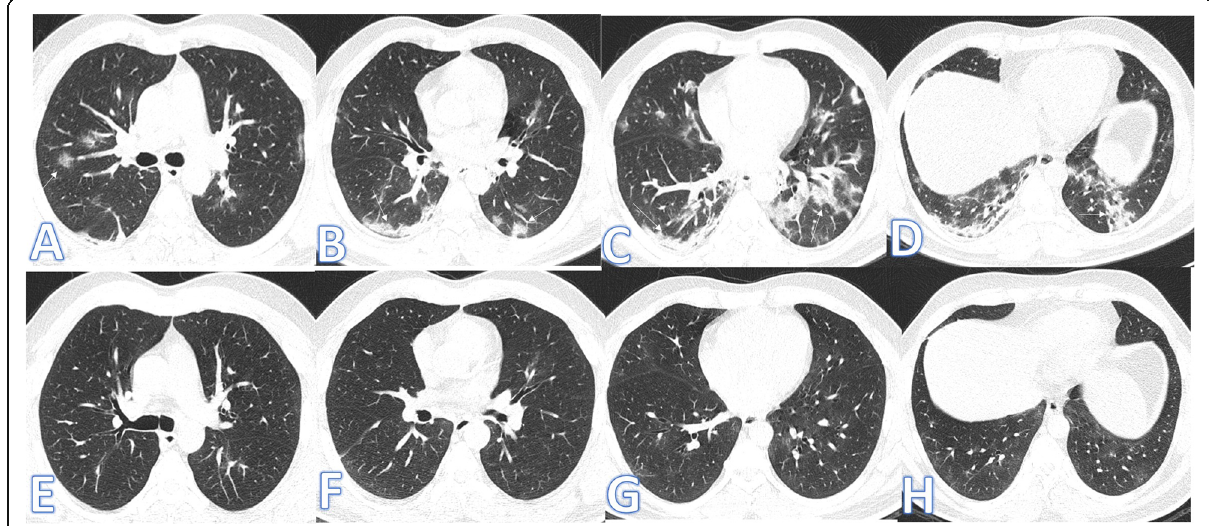
Fig. 9 Thirty-eight-year-old male: he has no previous medical illness; CT severity score 7, consolidation/crazy-paving score 4. No ICU admission; laboratory results showed normal lymphocytes, serum ferritin, and D -dimer and high CRP and D -dimer. Steroid was not given; length of stay during hospitalization is 2days. Peak CT during admission ( a – d ) showed bilateral peripheral consolidation patches mainly in the lower lobes with rounded GGO (arrows). Follow-up CT 1month after discharge ( e – h ) showed total resolution of the previous lung